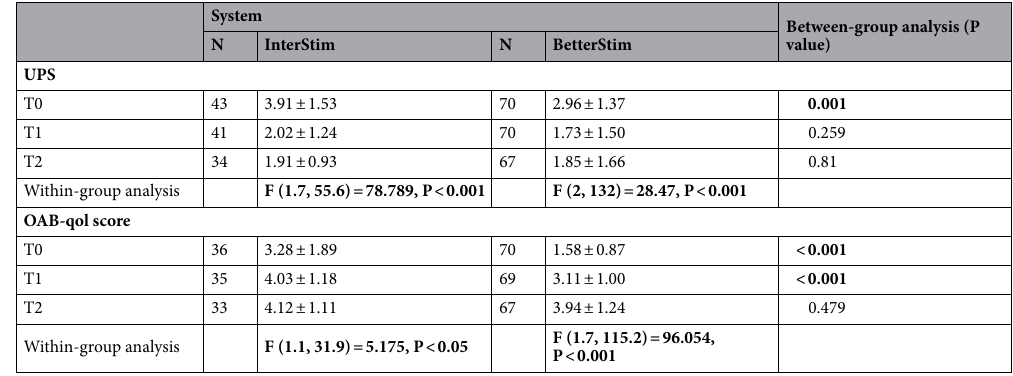
Table 3. Subjective indicator data. T0 baseline data, T1 experience period data, T2 last follow-up data, UPS urgency perception scale, OAB-qol overactive bladder related quality of life. Significant values are in